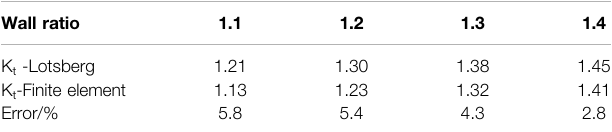
TABLE 4 | Model veri fi cation.